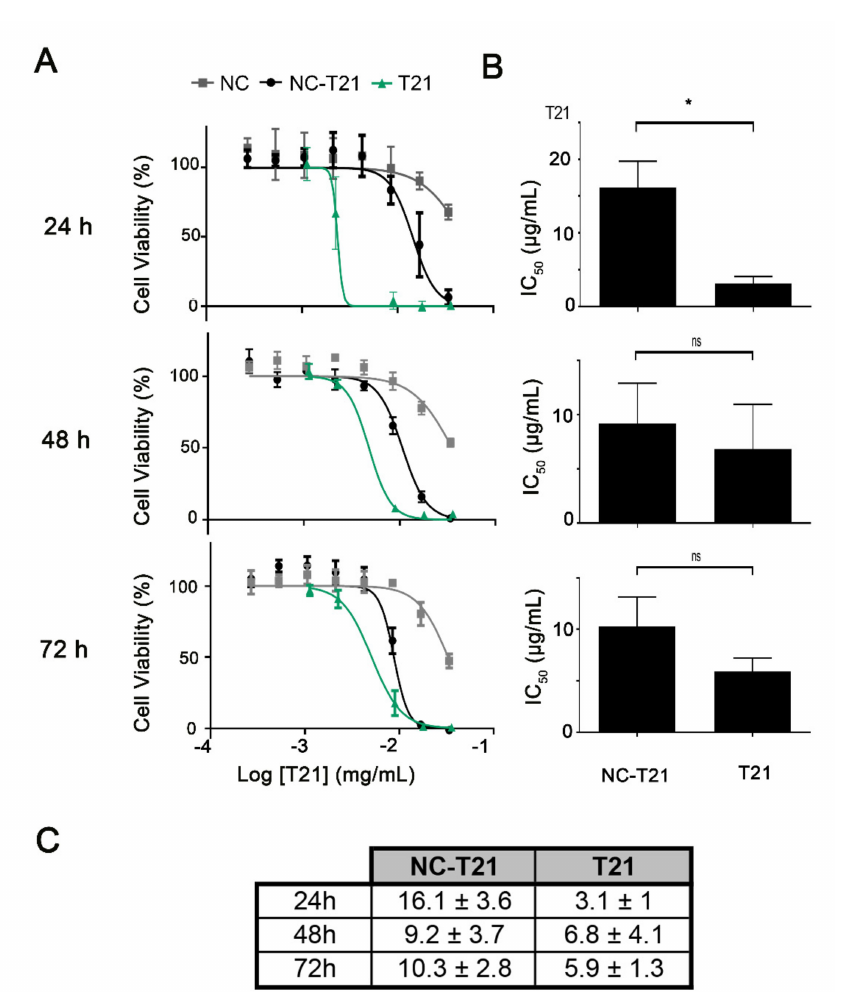
Figure 5. Cell viability in non-tumorigenic cells after treatment with free or encapsulated T21. Non-tumorigenic MCF10A cells were incubated with increasing concentrations of free (T21) and encapsulated T21 (NC-T21) or empty nanocapsules (NC) at pH 7.8 for 24, 48, and 72 h. ( A ) Cell viability was measured by MTT assay obtaining cell viability curves where IC 50 was extrapolated. ( B ) Comparison of the IC 50 values. * p < 0.05. ( C ) IC 50 values ( µ g/mL ± SD), obtained from dose-response